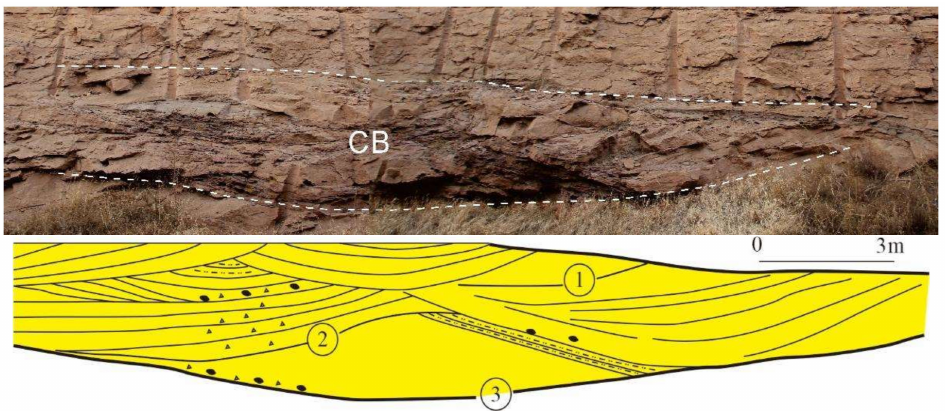
Figure 6. The typical composite bar architecture elements of the outcrop section of the Yungang Formation. The composite bar element comprises unit bars and chutes. 1 (cid:13) , 2 (cid:13) , and 3 (cid:13) represent channel bottom shapes of different periods,